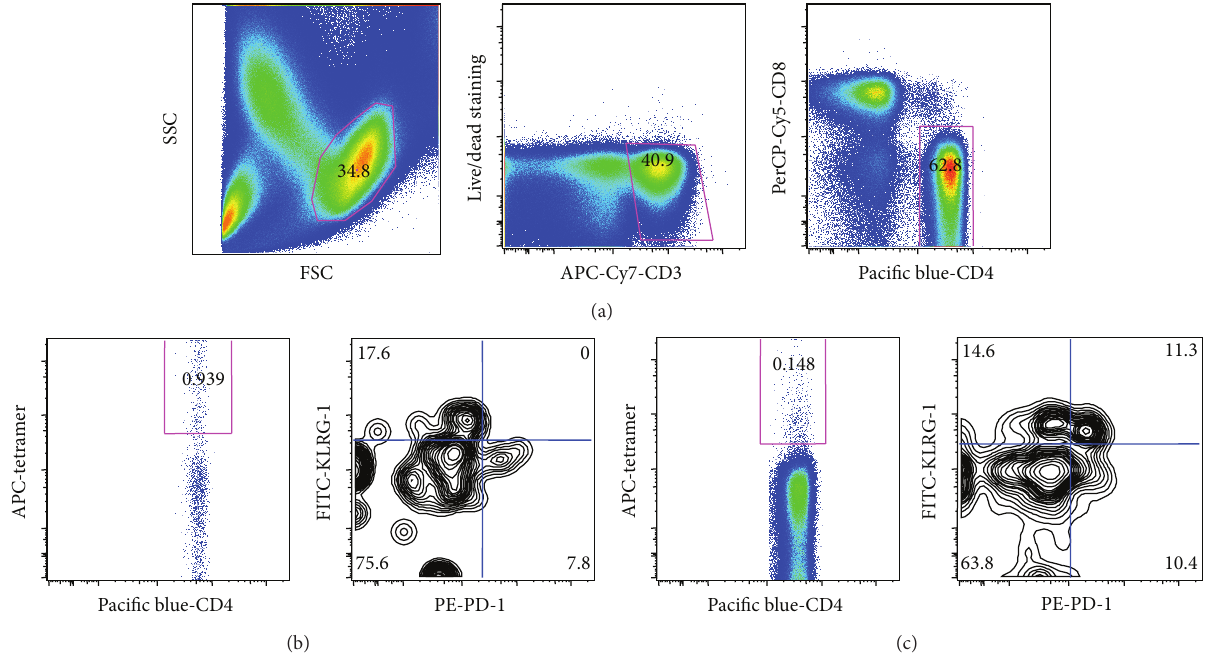
Figure 5: ESAT-6-specific CD4+ lymphocytes in active TB patients (b) and past TB patients (c) stained with MHC class II tetramers. Plots are gated on lymphocytes (by FSC and SSC), live CD3+ cells (by live/dead staining and CD3), and CD4+ cells (by CD4 and CD8) (a). The gated CD4+ lymphocytes are gated with MHC class II tetramer and KLRG-1 and